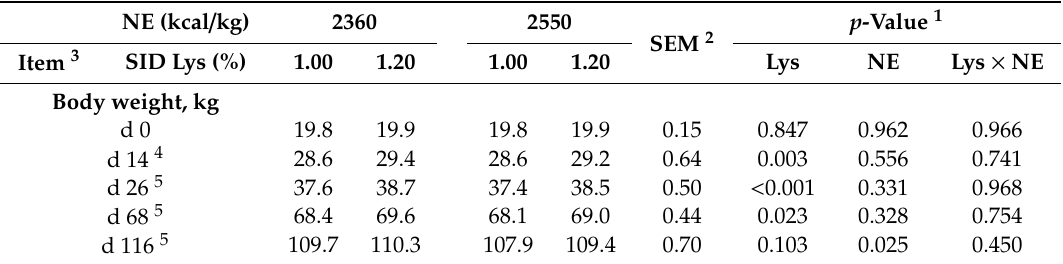
Table 3. E ff ects of increasing dietary standardized ileal digestible lysine (SID Lys) and reducing net energy (NE) concentration on growth performance of Pietrain grow-finishing pigs when fed the experimental treatments or a common diet (Experiment